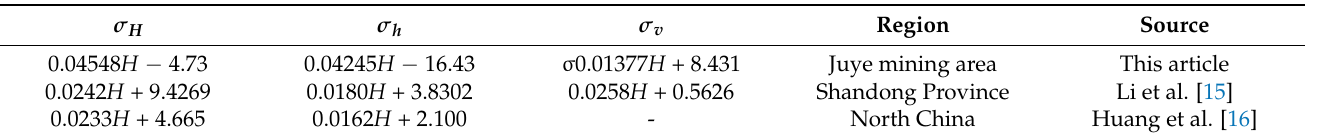
Table 4. Comparison of the principal stress variations with depth of the Juye mining area and other mining areas.